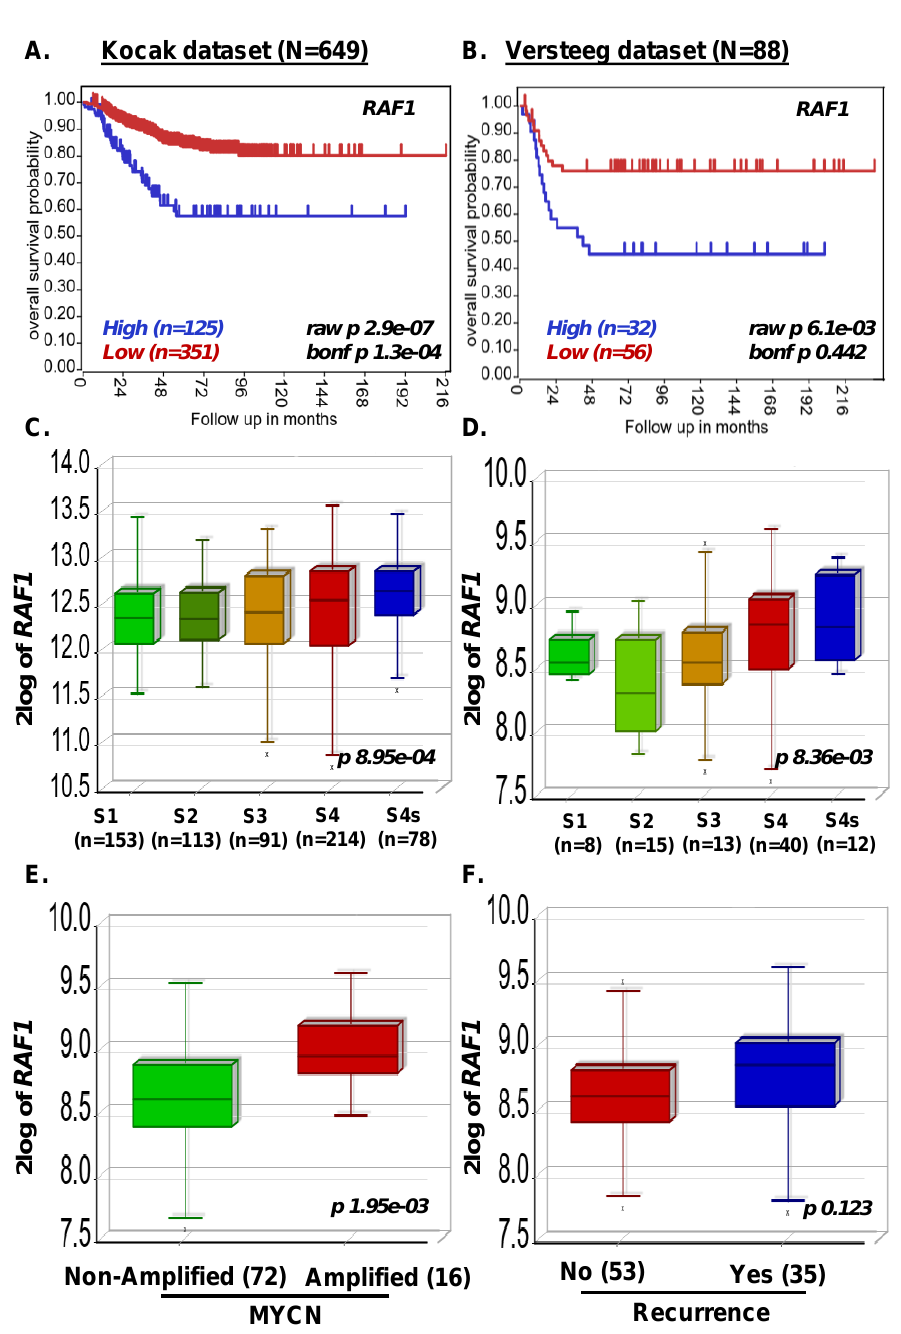
Figure 2. RAF1 expression correlates with poor overall survival of NB patients. Kaplan-Meier gene expression analysis of RAF1 shows poor overall survival of NB patients. ( A ) Kocak dataset ( n = 649 patients). ( B ) Versteeg dataset ( n = 88 patients). RAF1 expression correlates with NB stage progression in all patients dataset analyzed. ( C ) Kocak dataset. ( D ) Versteeg dataset. ( E , F ) Box-Plot correlation analysis in the Versteeg dataset revealed that higher RAF1 expression corresponds to ( E ) highly aggressive MYCN-amplified tumors, and ( F ) disease